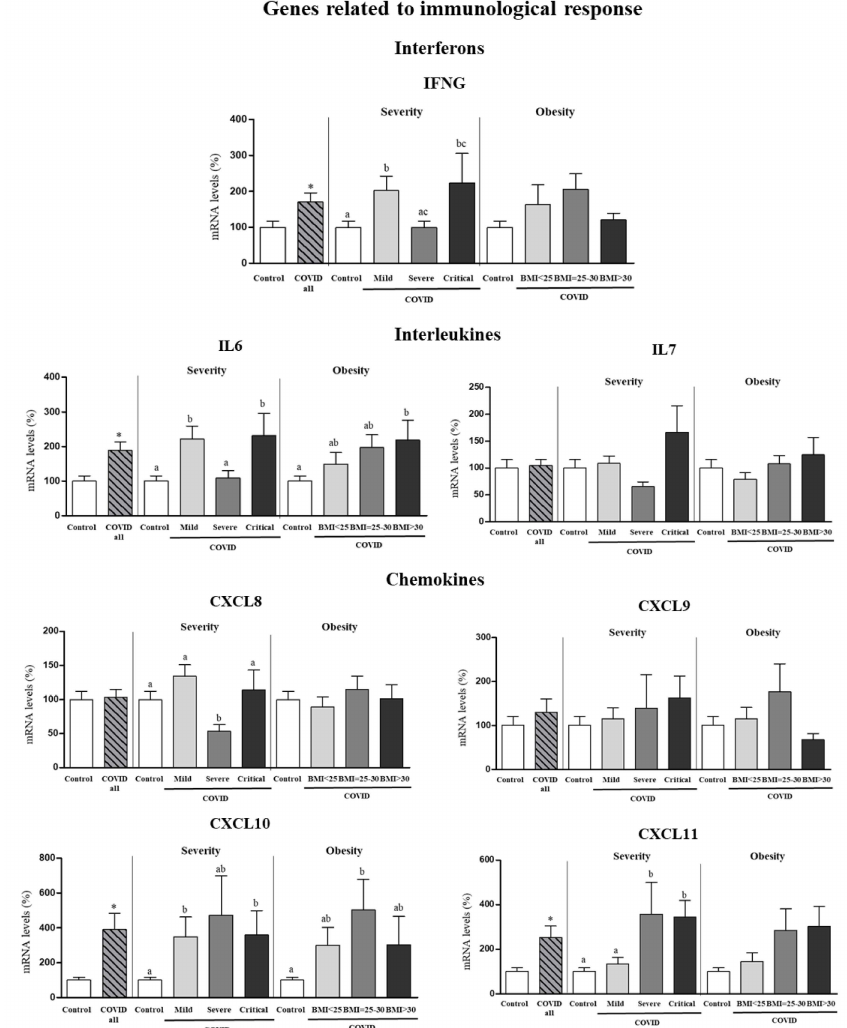
Figure 3. Expression levels in PBCs of the indicated genes related to immunological response in control subjects and COVID-19 patients (all) and separated according to COVID-19 severity and obesity. Pooled data from males and females are shown since no sex effects or sex × COVID interactive effects were detected for the indicated genes. mRNA levels were measured by real-time qPCR and expressed as a percentage of the value of control subjects (male and female). Data are expressed as the mean ± SEM. Statistics: differences between stratified groups were analyzed by one-way ANOVA followed by least significant difference (LSD) post-hoc test, a (cid:54) = b (cid:54) = c ( p < 0.05). Student’s t test was used for single comparisons: *, COVID all vs